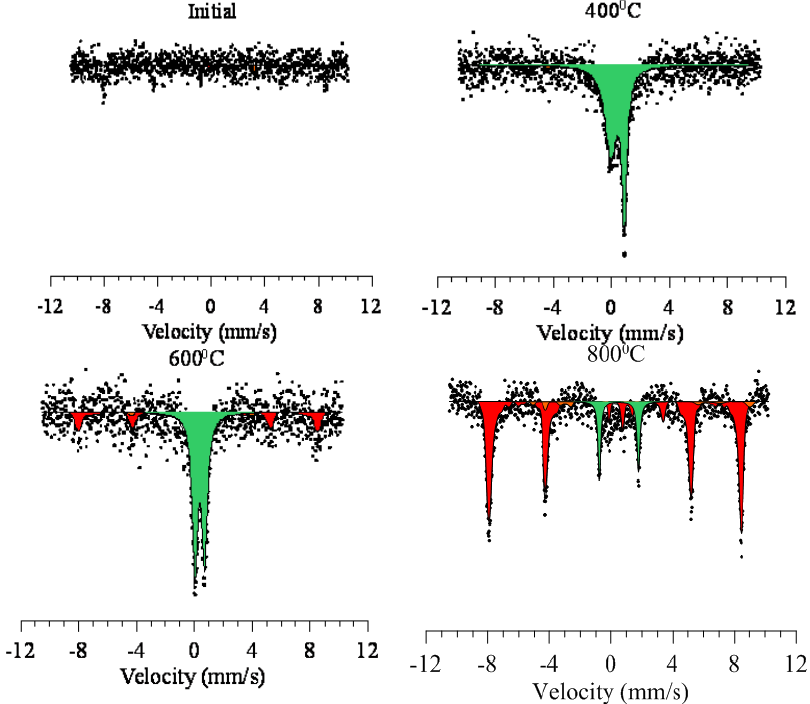
Figure 6. Mössbauer spectra of the studied nanoparticles before and after